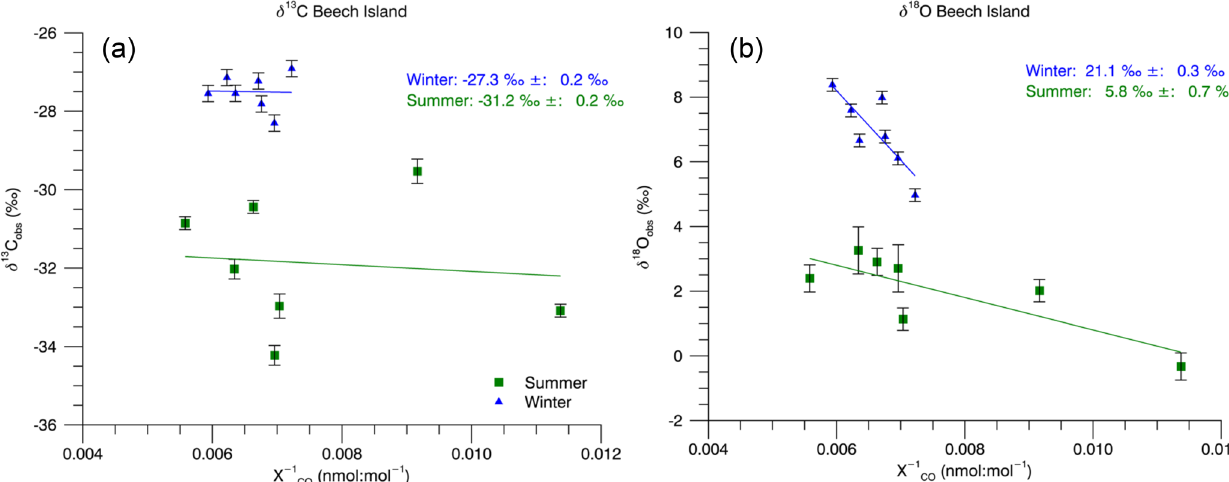
Figure 5. Beech Island Keeling plots. The reported intercepts and uncertainties are the standard Monte Carlo simulation results. We also performed a bootstrap Monte Carlo. Those results are reported in the